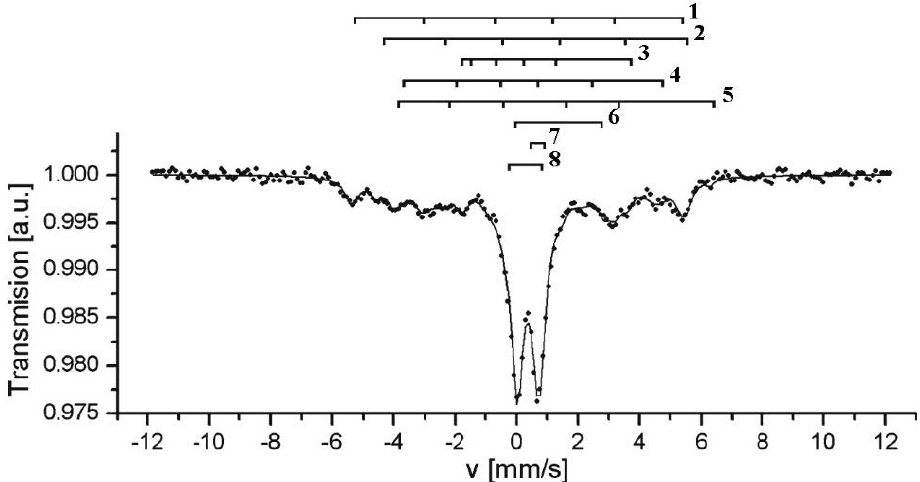
Figure 3. Room temperature Mössbauer spectra of the Zakłodzie ungrouped enstatite-rich achondrite. Indicated components are the result of the authors’ second fit (see [8] and the text above). Adapted from [8].